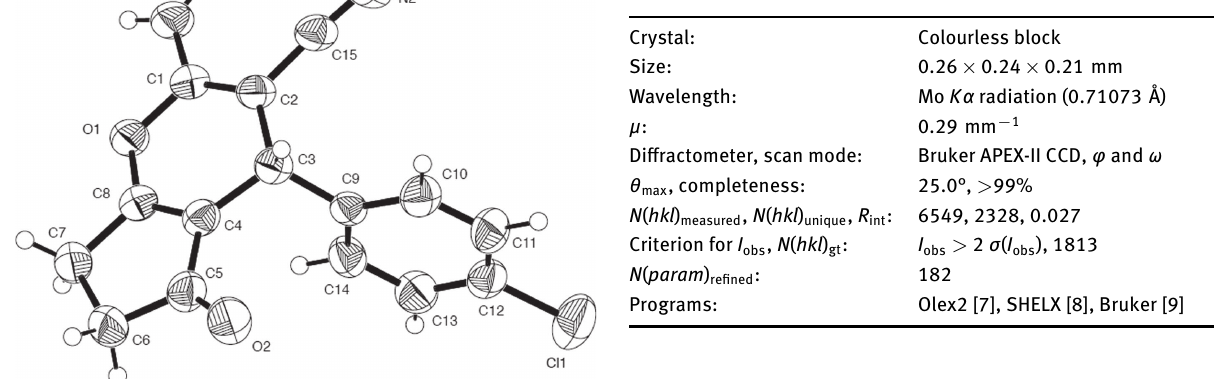
Table 1: Data collection and handling.